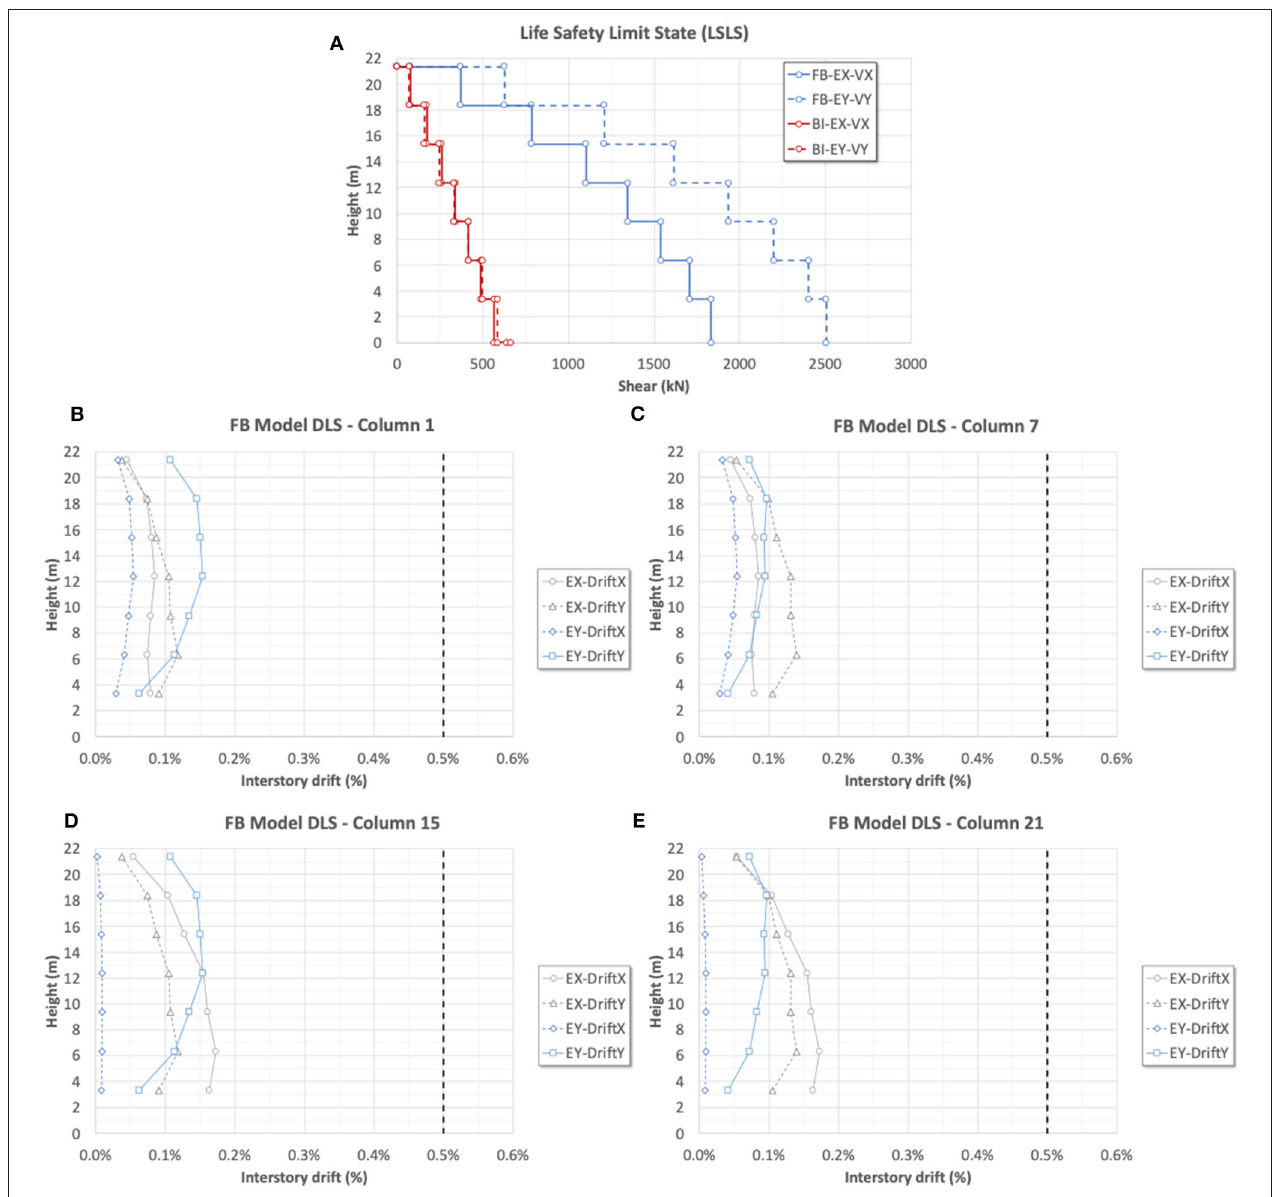
FIGURE 6 | FB model. (A) Shear floor distribution for LSLS. (B–E) Interstory drifts along the X and Y direction for DLS.